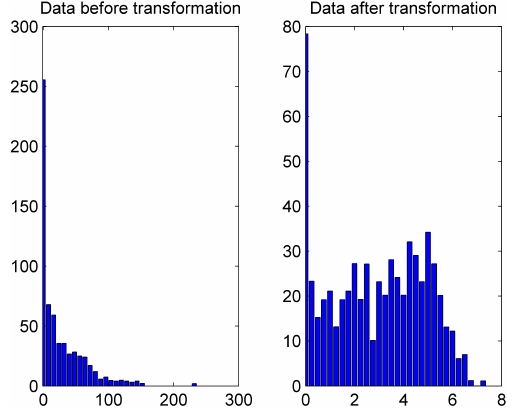
Figure 6. Monthly precipitation series before and after the Box–Cox transformation.